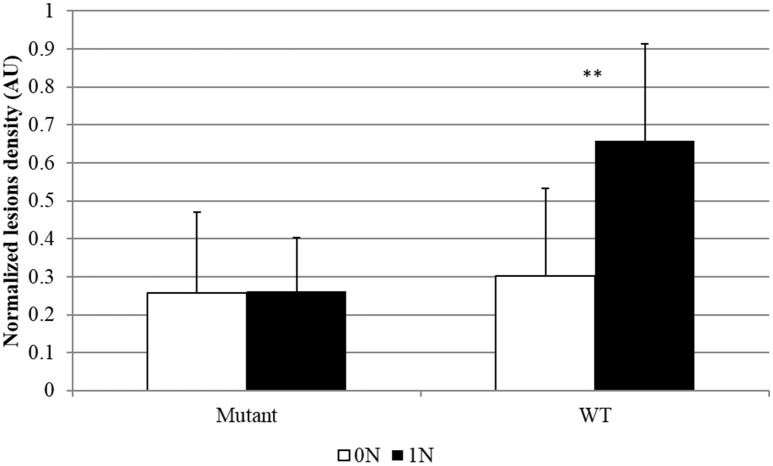
Rice blast symptoms in OsGS1-2 mutant and wild type lines. Mutants and corresponding Dongjin WT lines not containing the T-DNA were obtained from the T-DNA insertion line 1B10506 mutated in the OsGS1-2 gene (Only Heterozygous mutants-He- were found; see Supplementary Figure 6). Symptoms caused by M. oryzae (isolate Guy11) were estimated by counting the number of susceptible lesions 5 days after inoculation on eight different replicates. Different doses of nitrogen fertilization (0N, 1N; see Section Materials and Methods) were supplied to rice 1 day before inoculation. This experiment was repeated three times and 12 independent replicates were obtained. Data were normalized between the two replicates using the symptoms obtained for the most susceptible plants in each replicates. **Student test; p < 0.01.